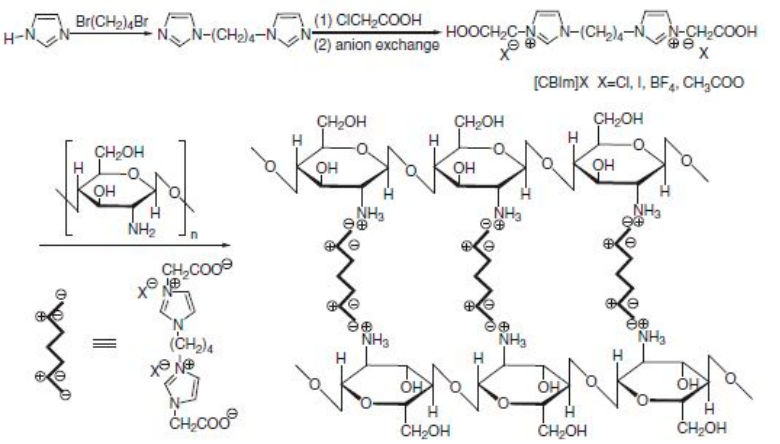
Figure 17. Schematic of the structure of CS-[CBIm]X composite membranes [230]. Copyright 2011, reproduced with permission from John Wiley and Sons